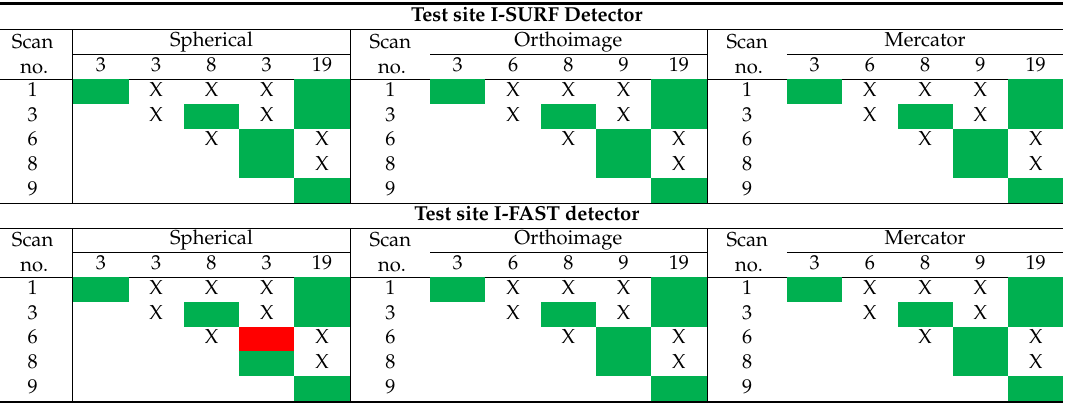
Table 5. The correctness of automated connecting of scans for Test Site I (both scenarios): Green, correct matching (full-registration), orange, preliminary orientation requiring the final registration using the ICP method, red, no matching, and “x”-means not connection for scans (no overlap).